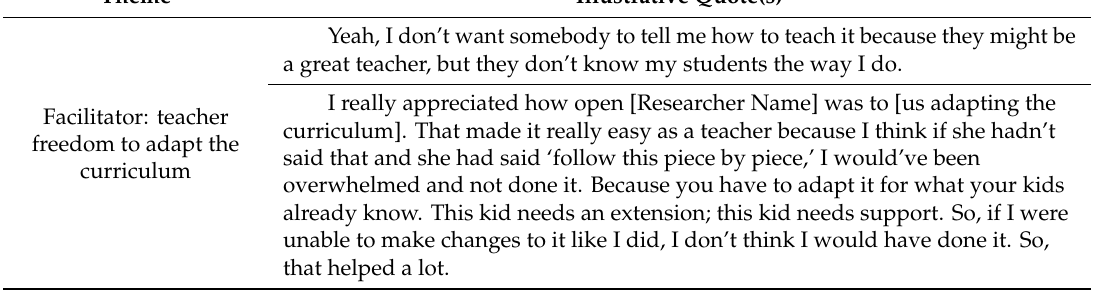
( c ) Figure 3. Food waste reduction poster winners, as voted on by school A ( n = 347) and school B ( n = 66) that were posted in school cafeteria during the final month of the intervention: ( a ) Top-voted poster at both schools ( b ) Second place poster at school A. ( c ) Second place poster at school B. 3.4. Classroom Survey Results A total of 268 students were enrolled in a 6th grade science class at the two schools and eligible for the study. About half of the students eligible ( n = 130, 50.4%) had parental consent and 97 students completed the classroom survey (36.2% of eligible students, 74.6% of consented students). Due to a technical error with the online survey platform, some students were unable to finish their classroom survey. Table 1 provides the demographic characteristics of students participating in the classroom survey, and Table 4 provides outcome results from the classroom survey measures. Table 4. Comparison of changes in classroom survey measures pre to post. Overall Mean ( SD )